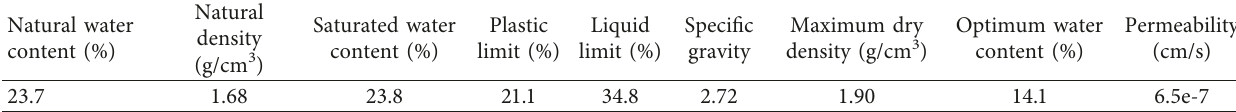
Table 1: Material properties of the compacted clay.